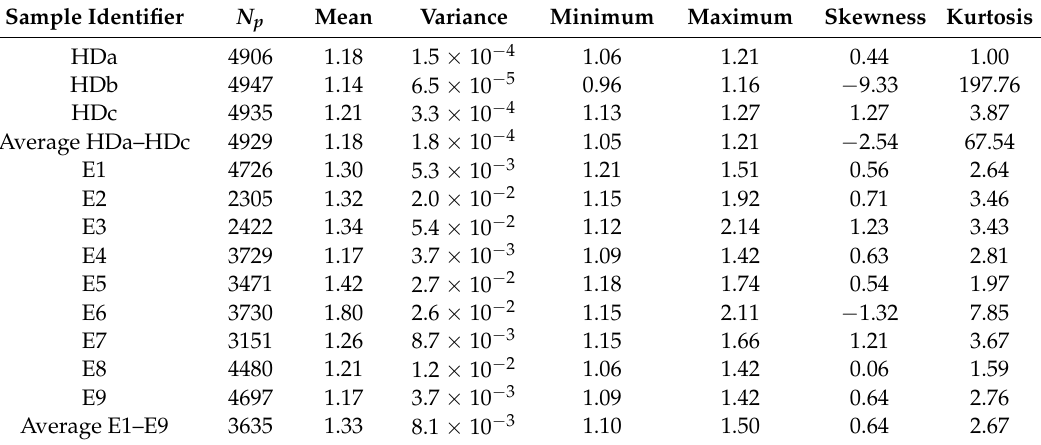
Table 3. Number of percolating particles, N P , and basic statistics of tortuosity, τ